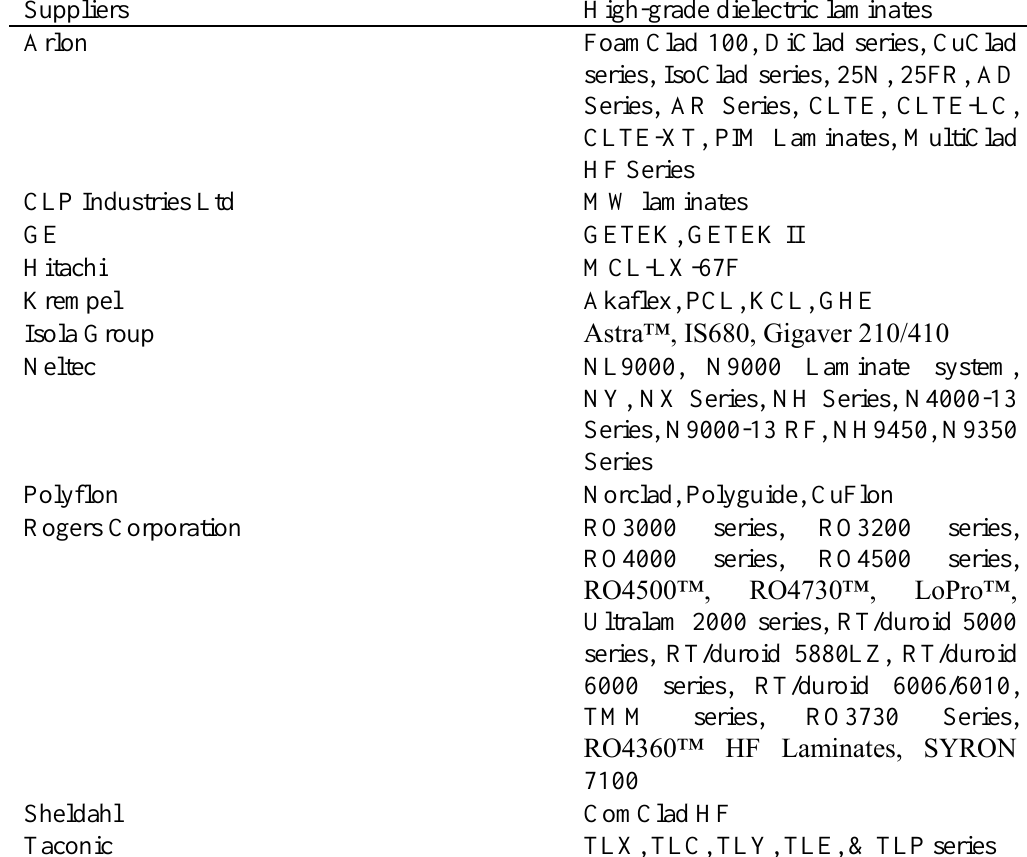
Table 2. List of high-grade dielectric suppliers & corresponding